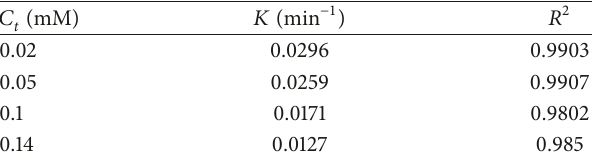
Table 1: Rate constant ( 𝐾 ) and correlation coefficient ( 𝑅 2 ) for different initial concentrations of